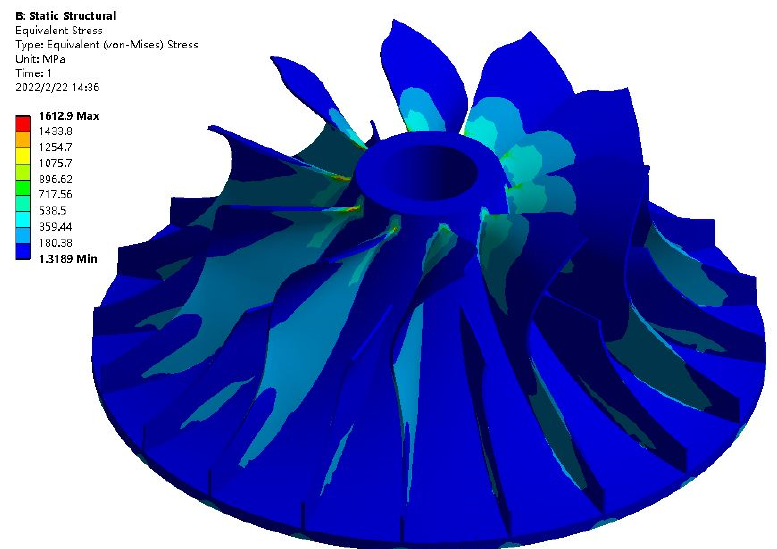
Figure 11. Equivalent stress distribution of Type A.